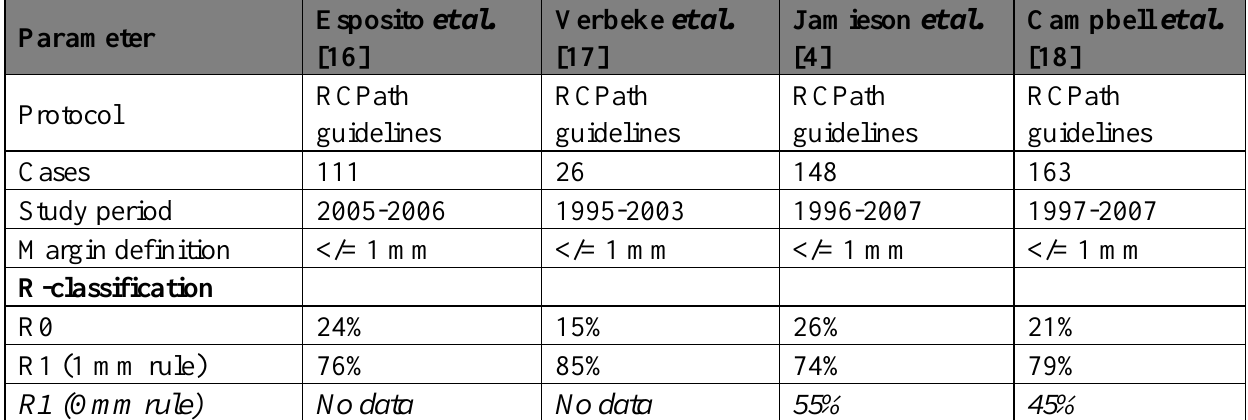
Table 2. Comparison of four large studies using a standardized